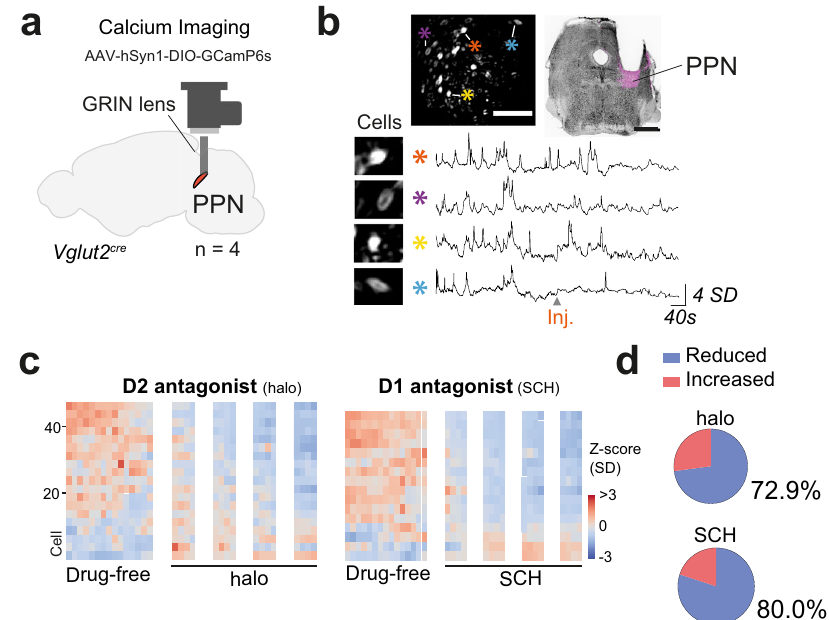
Fig. 5 Glutamatergic PPN neuronal population shows an overall decrease in activity after dopamine-receptor antagonism. a Microscope position and viral strategy were used to target the pedunculopontine nucleus (PPN) of Vglut2 cre mice ( n = 4) using AAV carrying Cre-dependent GCamP6s. b Left upper panel shows fi eld of view (FOV) with neuronal units expressing GCamP6s (scale 100 µ m, maximum deviation from average). The upper right shows a coronal slice with lens position above the PPN for the same animal, where GCamP6s expression is stained in magenta (scale 1 mm, − 4.84mm from bregma, NeuroTrace in black). The lower panel shows insets of neuronal shape extracted from four cells identi fi ed in the FOV (*) and their respective activity traces ( Z -score in units of SD). c Calcium dynamics of Vglut2-PPN neurons before and after haloperidol (left, 48 cells) or SCH (right, 40 cells). Heat map bins of 50 s. Reduction in signal upon drug injection (Spearman ’ s correlation: PPN halo r s = − 0.8747, PPN SCH r s = − 0.9626). d Pie charts show the fraction of all neurons that decreased (blue) or increased (red) their activity during PD state as compared to a drug-free period (for detailed analysis see Fig. S2d – g). Data are presented as Z -score in units of standard deviation (SD) from the baseline value, extracted from the 24 min recording. See also Fig. S2 and detailed stats in Table S2. Source data are provided as a Source Data fi